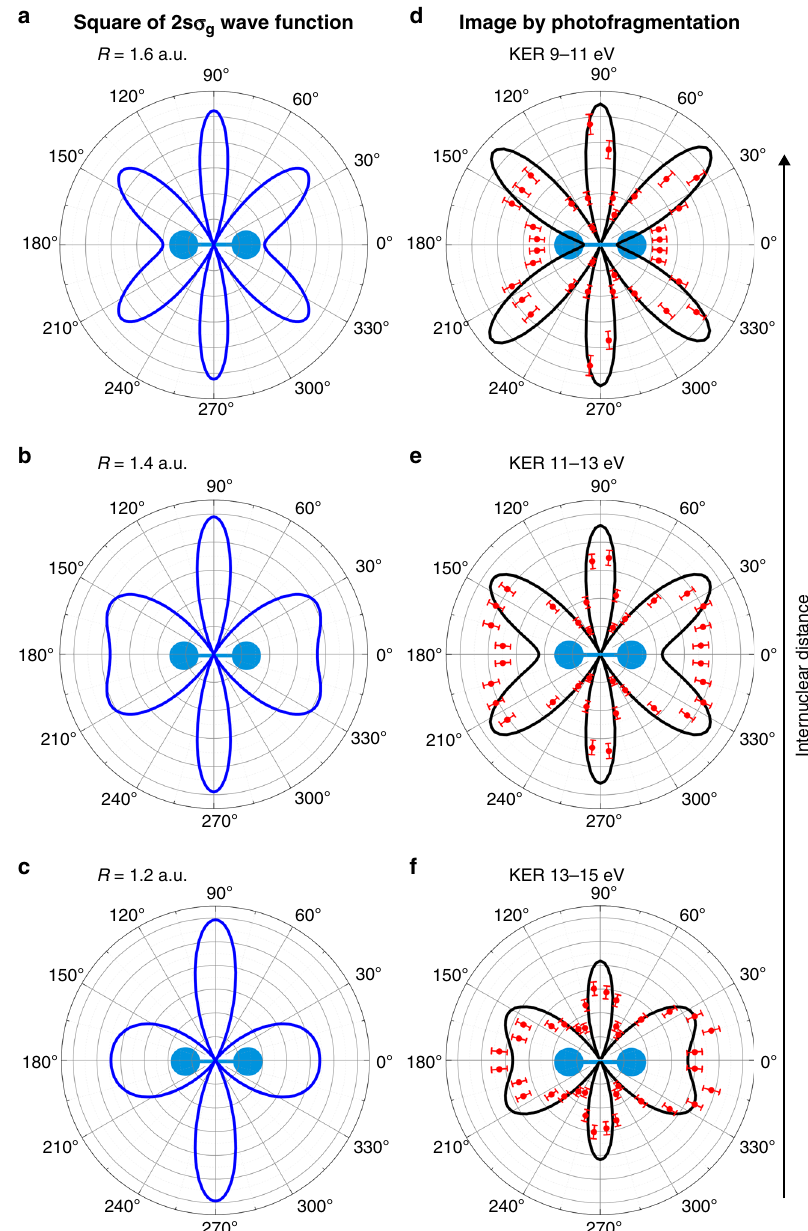
Fig. 4 Dependence of the momentum distribution on the internuclear distance R a – c and KER d – f of the molecule at the instant of photoionization. Molecular orientation as indicated. a to c : Square of the correlated wave function, as shown in Fig. 2h, but for internuclear distances as stated in the legends. Electron B is projected onto the 2 s σ g state while electron A is depicted. d – f : Experimental and theoretical MFPADs (symbols and black line, respectively) for the KER ranges corresponding to the internuclear distances in a , c resulting from applying the re fl ection approximation through the 2 s σ g potential energy curve. The error bars indicate the standard deviation of the mean